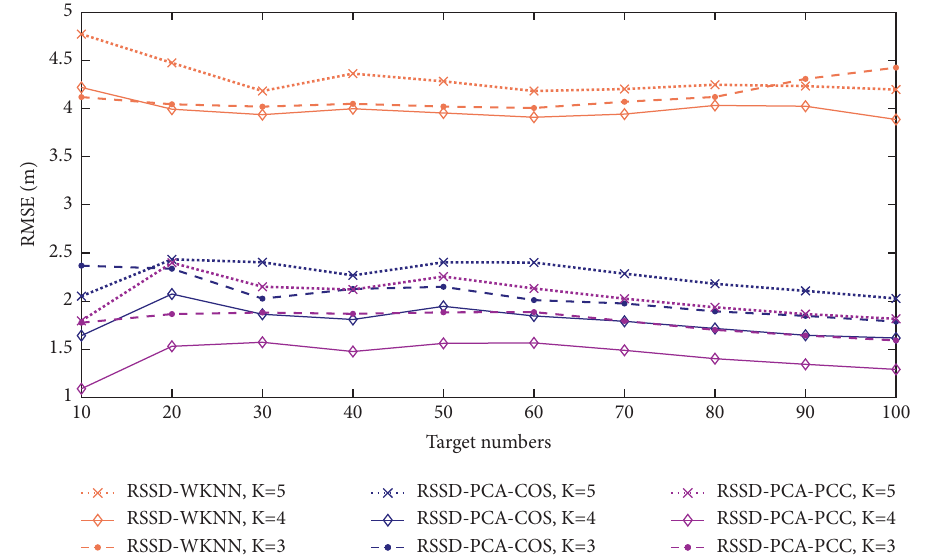
Figure 8: RMSE comparisons among RSSD-WKNN, RSSD-PCA-COS, and the proposed RSSD-PCA-PCC when the number of positioning targets changes from 10 to 100 with 2m grid distance and 4 APs.